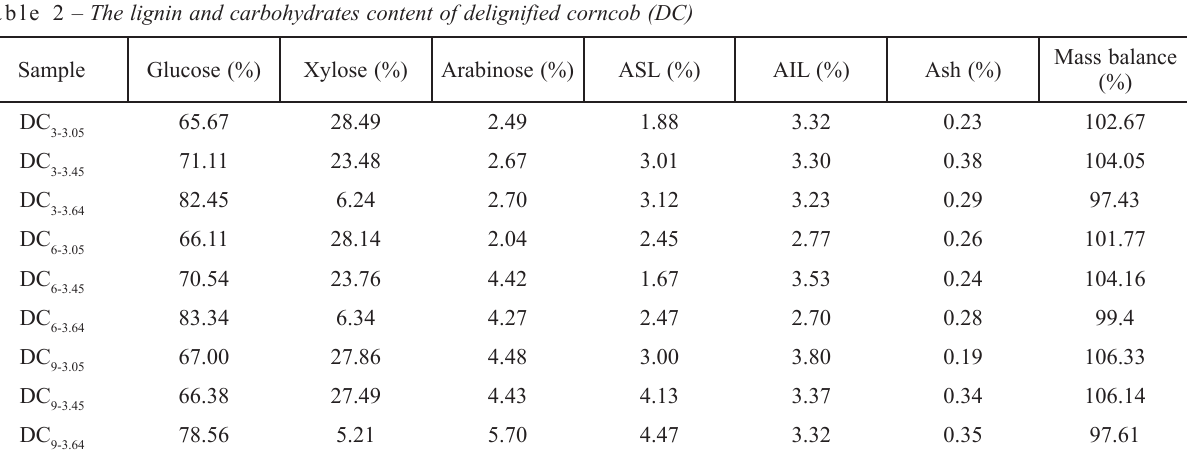
Table 3 – The assignments of l-SSA with different NaoH catalyzed concentration and steam explosion severity Assignments/cm –1 C–H out of plane in positions 2, 5 and 6 (G + S unit)/833